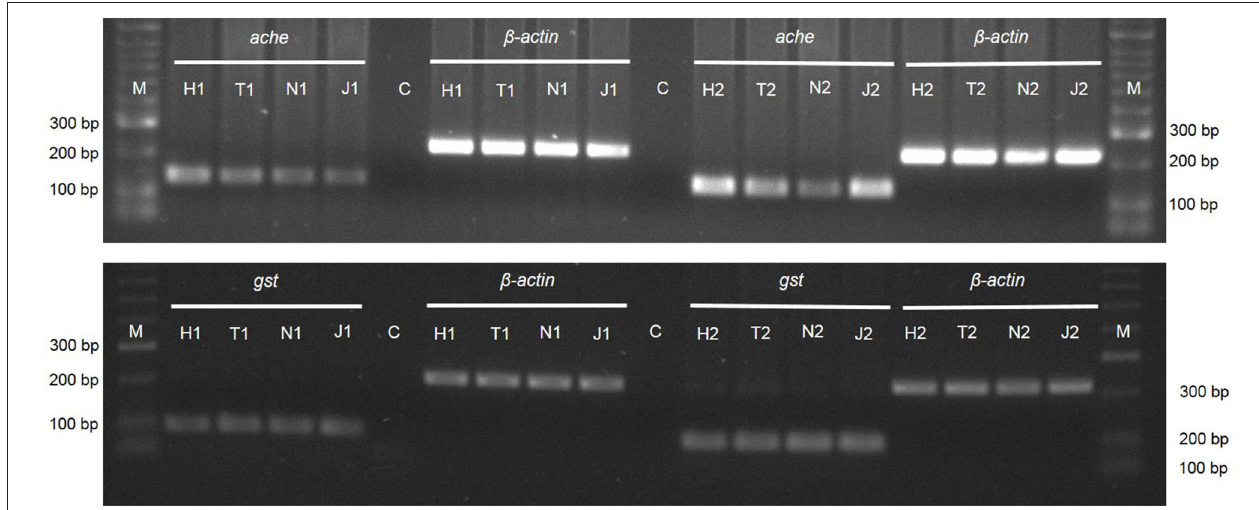
FIGURE 7 | Expression of the genes acetylcholinesterase ( ache ), glutathione-S-transferase ( gst ) and β -actin by PCR amplification of cDNA from Meloidogyne luci second-stage juveniles after exposure for 24h (1) and 72h (2) to 1,4-naphthoquinone (N) and juglone (J) 20 ppm. Water (H) and Tween ® 80 at 2,500 ppm (T) were used as controls. M - DNA Marker (HyperLadder II;